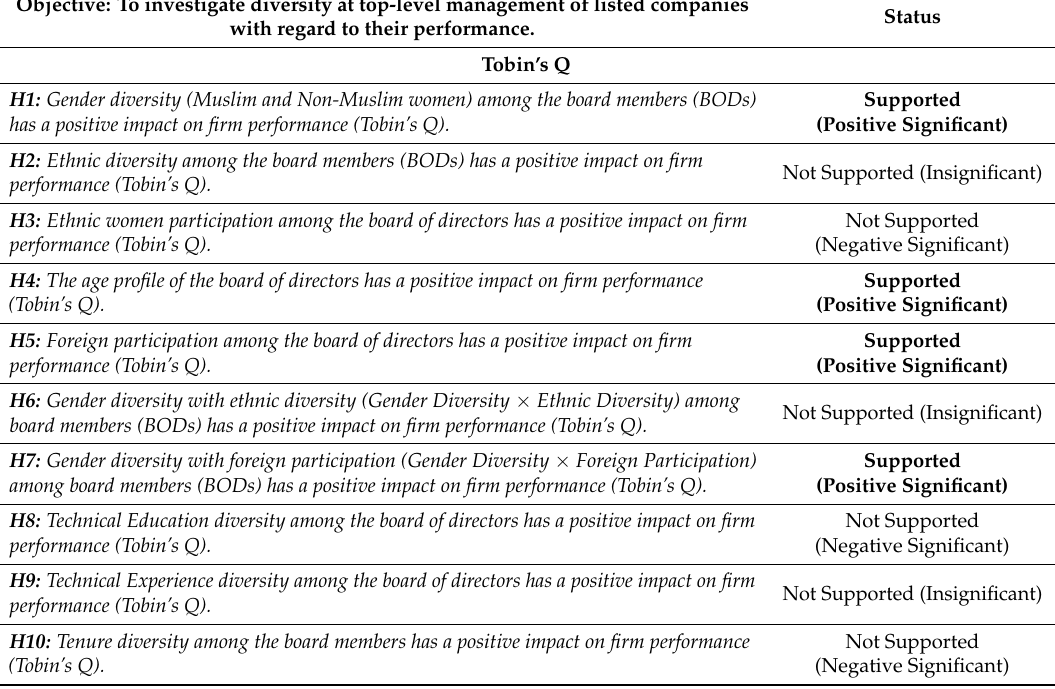
Table 5. Summary results of the hypotheses